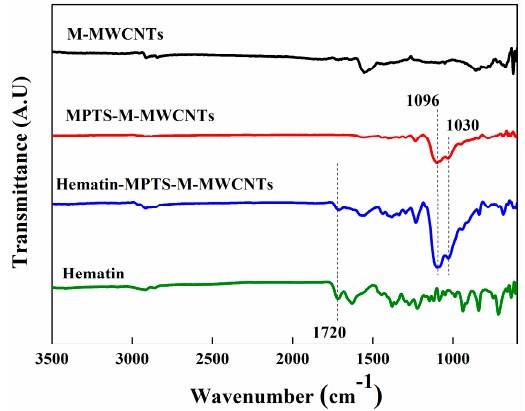
Figure 2. Fourier transform infrared spectra for functionalized carbon nanotubes. MWCNTs: black: magnetic (M-MWCNT); red: MPTS-coated (MPTS M-MWCNT); blue: hematin functionalized (hematin-MPTS-M-MWCNT).